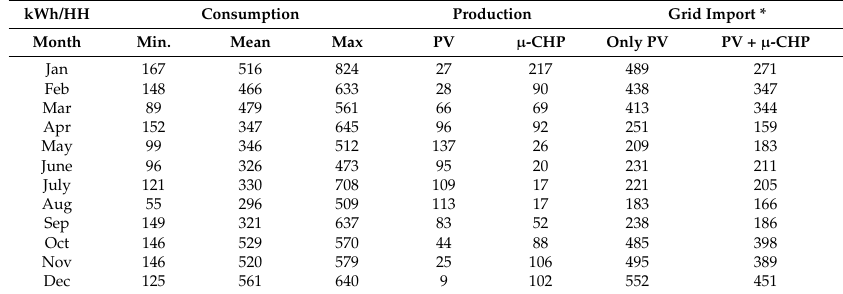
Table 5. Monthly electricity consumption, production, and grid import on average per household for 12 households with heat pumps and 10 households with µ -CHP.